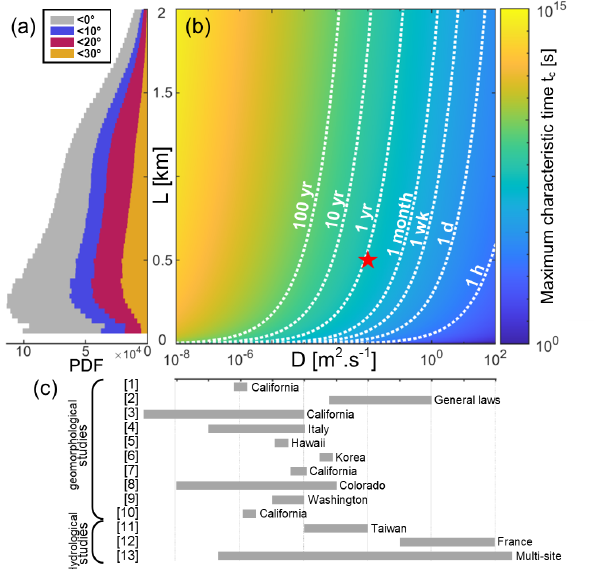
Figure 8. Maximum characteristic timescale of hillslopes response depending on diffusivity D and hillslope length L . The his- togram (a) shows the distribution of hillslope lengths in Taiwan, extracted from a 30 × 30m DEM. The maximum characteristic hill- slope response time L 2 /D is presented in (b) , with the point cor- responding to the values used in this study highlighted. Values of diffusivity found in the literature are displayed in (c) . Sources from the diffusivity graph (c) are: [1] Iverson (2000); [2] Goren and Aharonov (2007); [3] Handwerger et al. (2013); [4] Berti and Simoni (2012); [5] Reid (1994); [6] Kim et al. (2010); [7] Hu et al. (2019); [8] Schulz et al. (2009); [9] Baum et al. (2010); [10] Finnegan et al. (2021); [11] Chien-Yuan et al. (2005); [12] Jiménez-Martínez et al. (2013); [13] Pacheco (2013). Hillslope length in Taiwan is measured by considering the nearest hydrologi- cal distance between crests and rivers, considering that the transition between rivers and hillslopes occurs at 0.9km 2